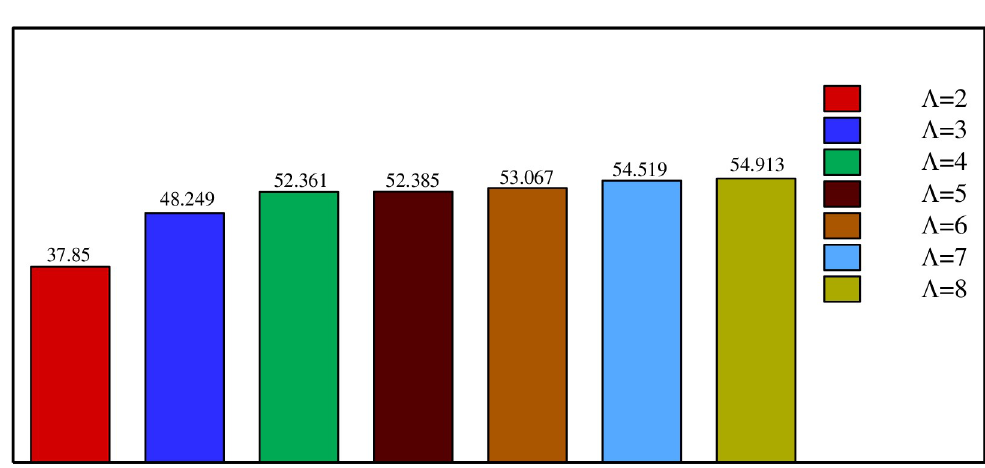
Fig 17. Comparison between the powers (W/m) on various the number of petals of the quasi-petal heat pipe when r 0.6 r s , A = 0.15 r s , and η = π